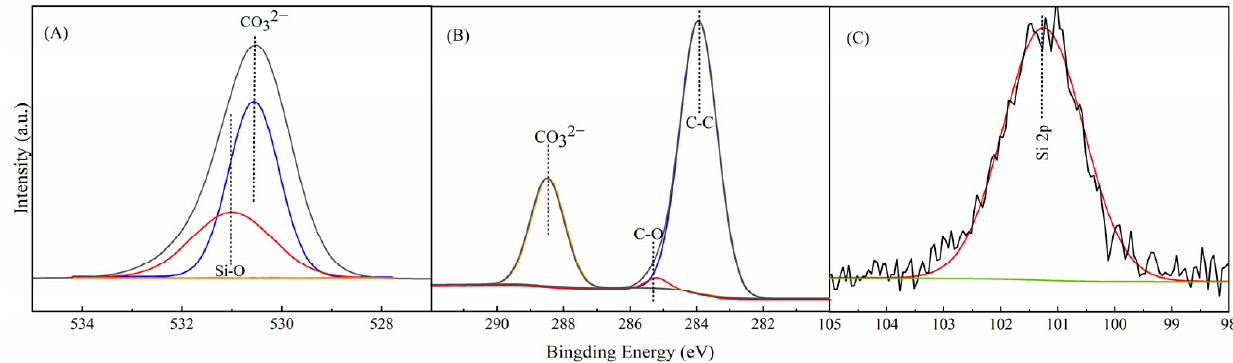
Figure 3. XPS profiles of O 1s ( A ), C 1s ( B ), and Si 2p ( C ) for MNC.